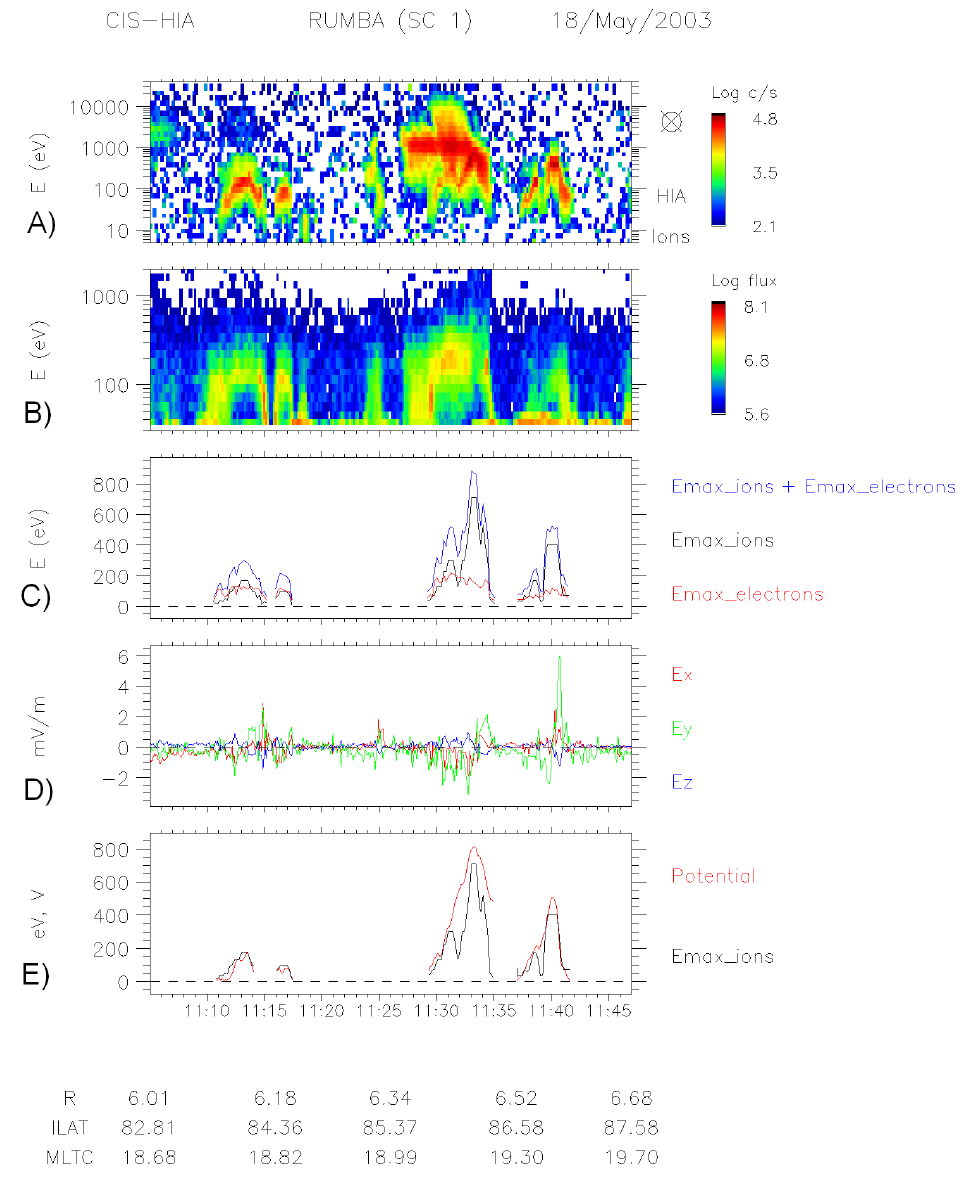
Fig. 12. 18 May 2003. (A) Energy-time spectrogram from HIA for all ions. (B) Energy-time spectrogram from PEACE for downgoing electrons. (C) Comparison of the energy of ions (upflowing, back) and electrons (downgoing, red) at maximum of fluxes. The total energy (upflowing ion energy + downgoing electron energy) is plotted in blue. (D) GSE components of the perpendicular electric field as given by EDI, spacecraft 1. (E) Electric potential along the spacecraft trajectory (red curve) computed from EDI data and energy of the maximum of ion fluxes (black